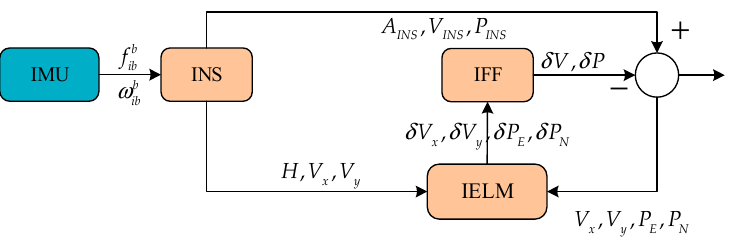
Figure 5. Prediction mode based on the IELM during GPS outages.